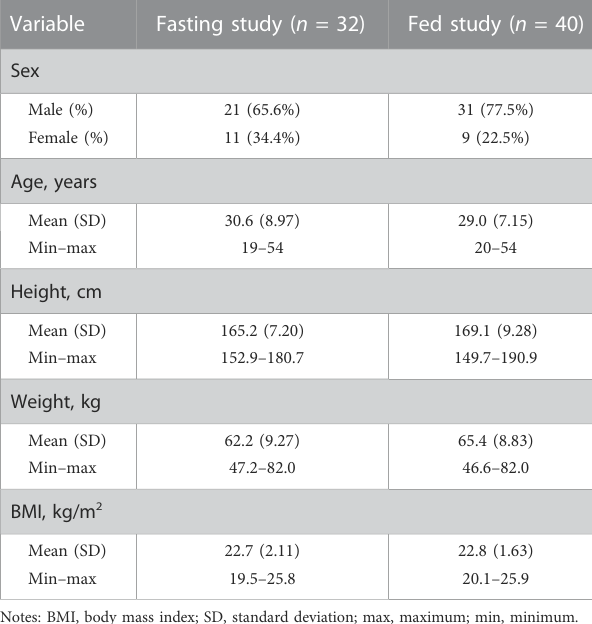
Table 1 . A total of 32 subjects completed the whole study under